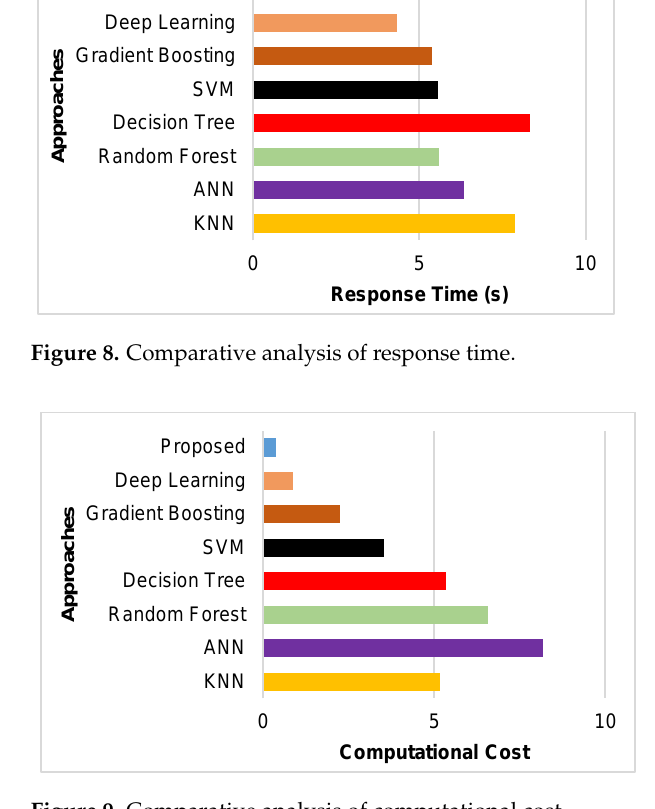
Figure 9. Comparative analysis of computational cost.